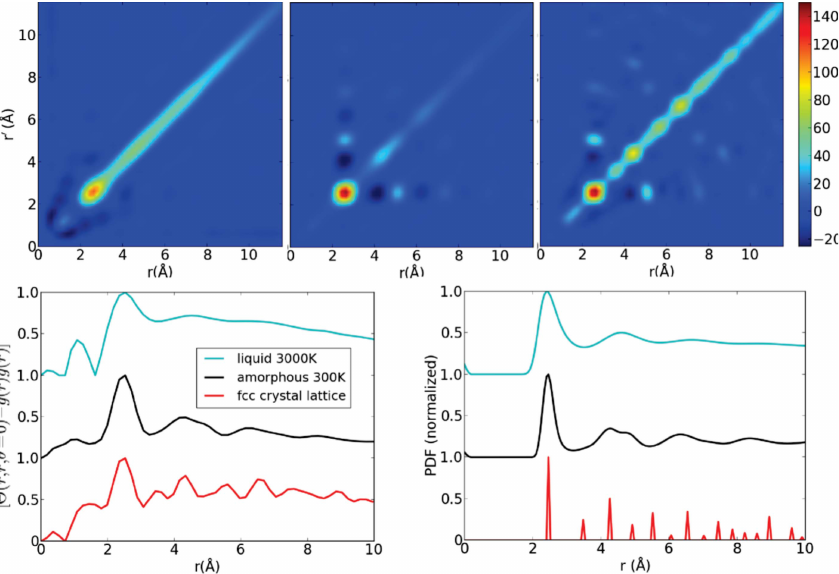
Figure 2 When evaluated at (cid:2) ¼ 0, (cid:2) ð r ; r 0 ;(cid:2) Þ provides information about radial correlations. The top row shows the (cid:2) ð r ; r 0 ;(cid:2) ¼ 0 Þ extracted from diffraction simulations of liquid Ni at 3000 K (left), amorphous Ni at 300 K (middle) and an f.c.c. Ni crystal (right). On the bottom left we plot the r ¼ r 0 diagonal which contains peak structure that is similar qualitatively to the pair distribution function (bottom right). All line plots have been normalized to have a maximum value of 1 to aid comparison. The information less than 2.5 A˚ is a numerical artifact related to the finite resolution of the